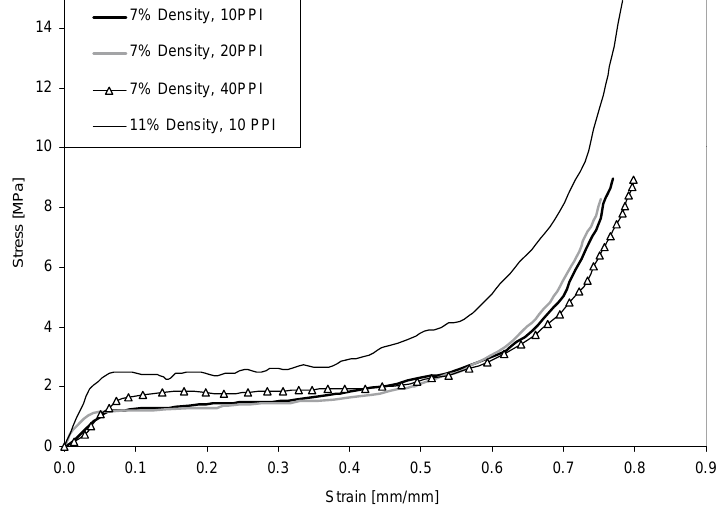
Fig. 4. Low rate ( 0 . 01 s − 1 ) stress-strain curves for open-celled aluminum